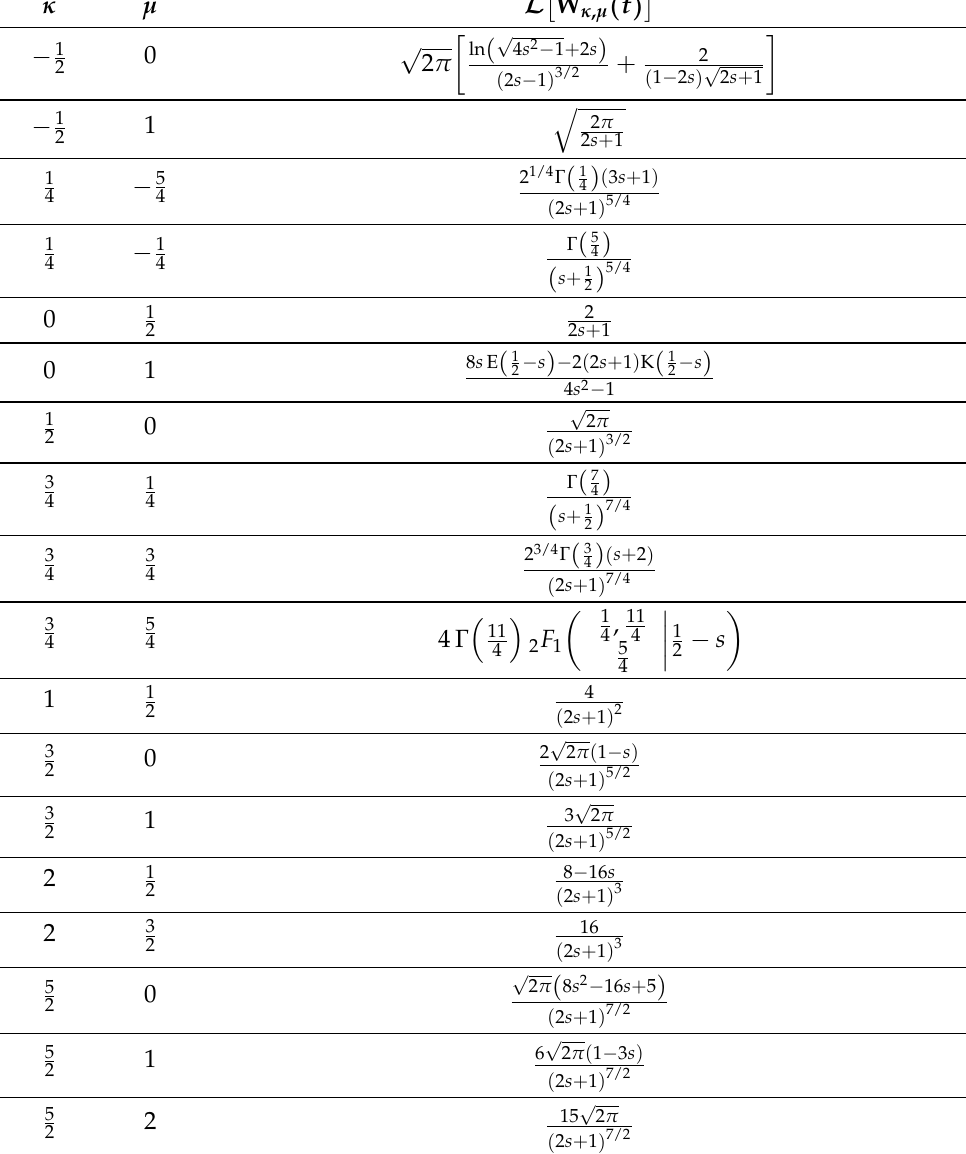
Table A12. The Laplace transforms of the Whittaker function W κ , µ derived for some values of parameters κ and µ